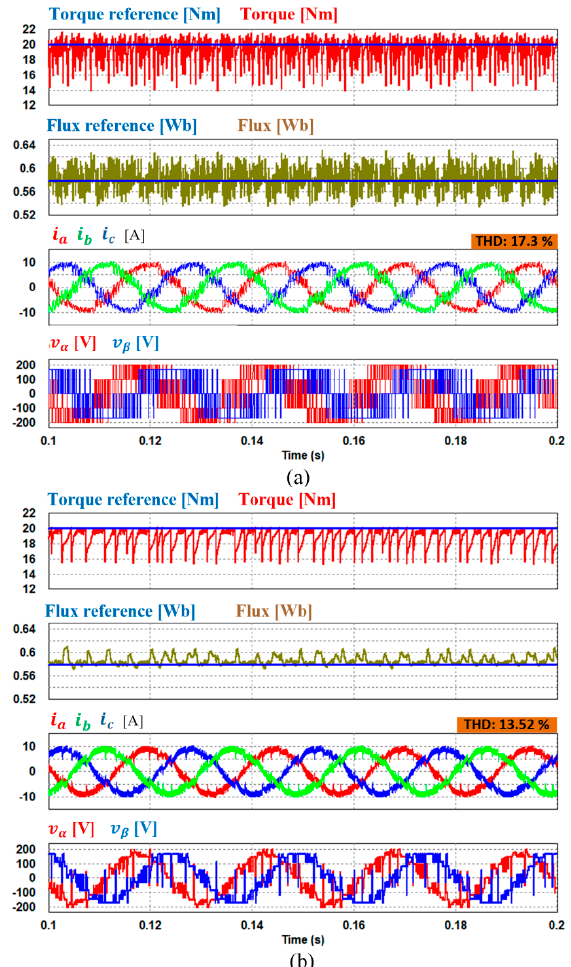
Figure 6. Simulation results for the steady-state response of the PMSM at 800 rpm, 20 Nm. ( a ) Conventional finite set-predictive torque control (FS-PTC); ( b ) proposed PTC-DSVM.